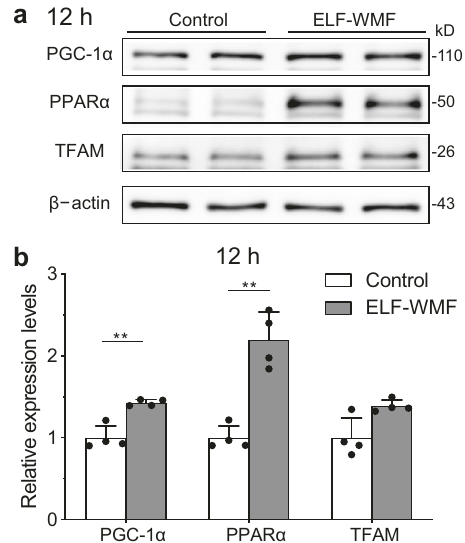
Fig. 5 Opti-ELF-WMF induced mitochondrial biogenesis. a Representative duplicates of Western blot analysis are shown. b Densitometric analysis of Western blots (mean ± SD, n = 4 culture dishes each; * q < 0.05 and ** q < 0.01 by multiple Student ’ s t